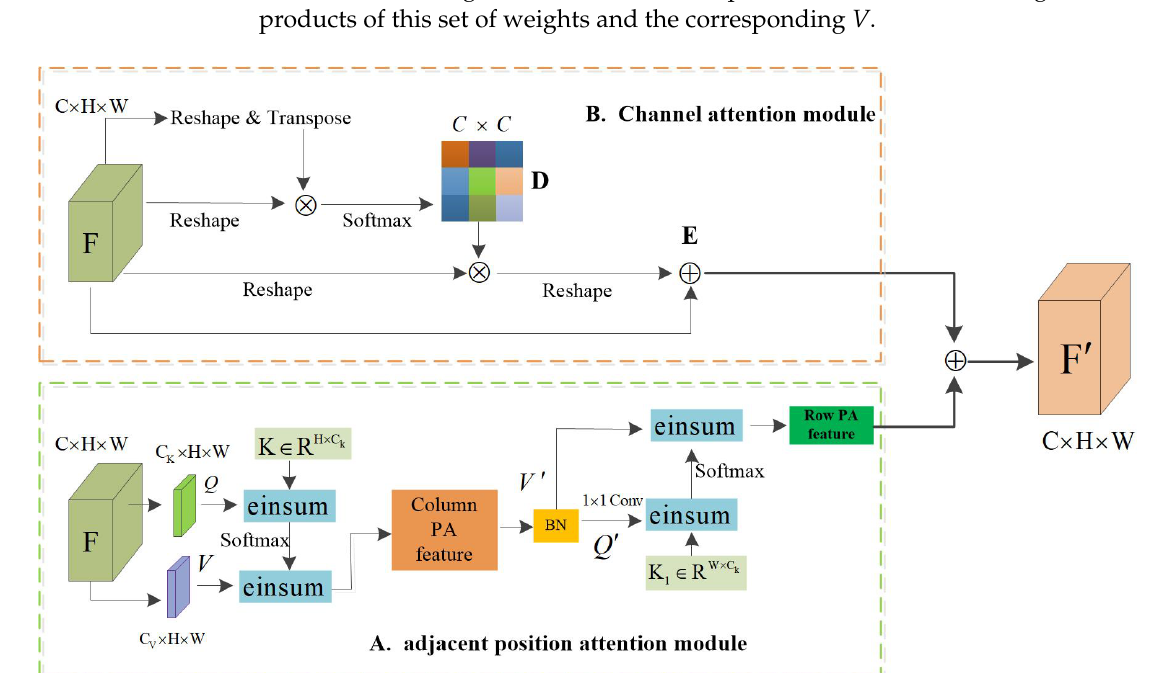
Figure 3. The overall framework of the new dual-attention model (NDAM). The details of the Adjacent Position Attention Module and Channel Attention Module are illustrated in ( A , B